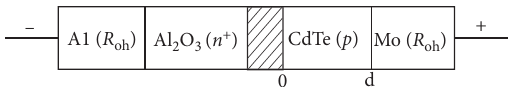
Figure 1: Scheme of Al-Al